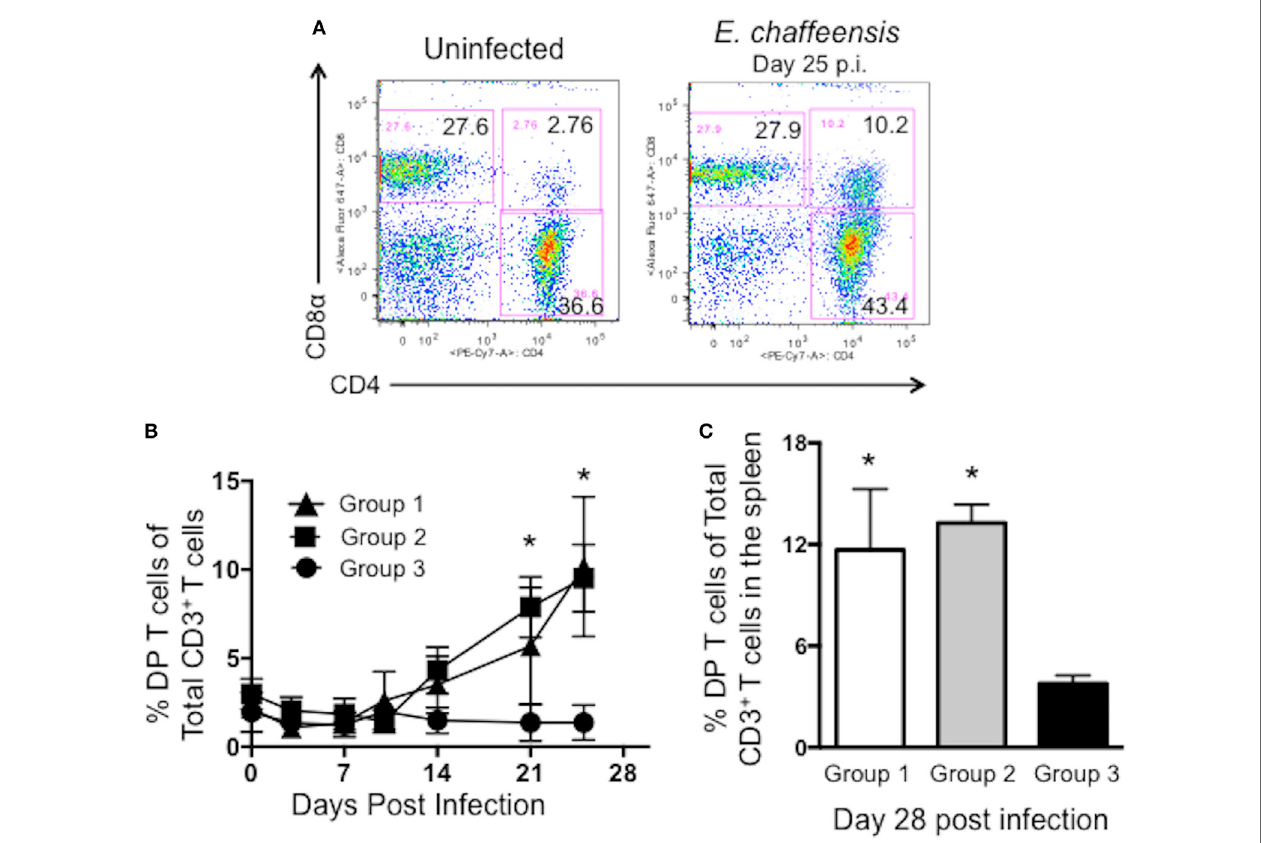
FigUre 3 | Canine CD4 + CD8 + double-positive (DP) T cells expand in the peripheral blood and spleen during Ehrlichia chaffeensis infection. Peripheral blood was collected from dogs in groups 1–3 on days 0, 3, 7, 10, 14, 21, and 25 post-infection and analyzed by flow cytometry for the frequency of circulating CD3 + CD4 + CD8 + DP T cells. (a) Representative flow plots from an uninfected and E. chaffeensis infected dog on day 25 post-infection. Plots are gated on live cells, lymphocytes, and CD3 + cells. A representative gating strategy is depicted in Figure S1 in Supplementary Material. (B) Aggregate results from each dog collected over the course of the experiment. Group 1 was vaccinated with the Ech_0230 mutant and challenged with wild-type E. chaffeensis ; group 2 was unvaccinated and infected with wild-type E. chaffeensis ; and group 3 was uninfected. * p < 0.05 compared to uninfected controls (group 3) as determined using two-way ANOVA with Sidak’s multiple comparisons test. (c) Animals were euthanized on day 28 post-infection. Samples of spleen were processed into single cell suspensions and analyzed by flow cytometry for the frequency of live, CD3 + CD4 + CD8 + DP T cells among all CD3 + T cells. Data represent mean ± SEM. * p < 0.05 compared to uninfected controls (group 3) as determined by one-way ANOVA with Tukey’s